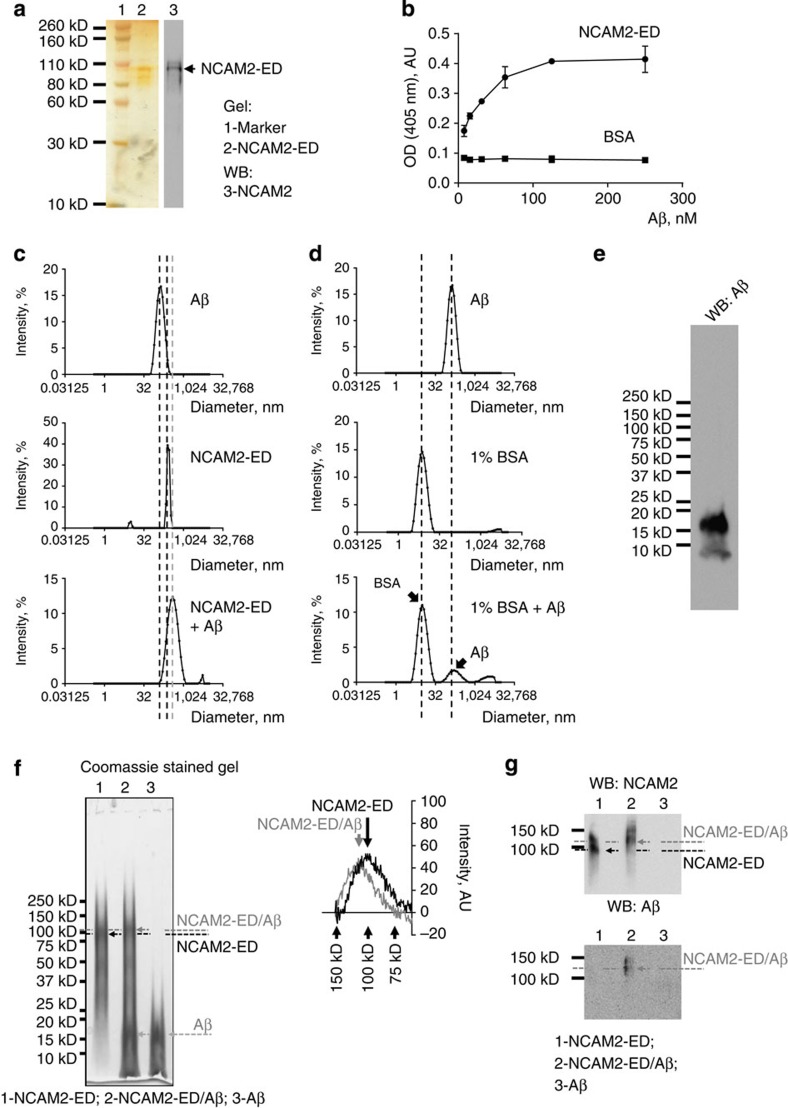
The extracellular domain of NCAM2 binds to Aβ.(a) Recombinant extracellular domains of NCAM2 (NCAM2-ED) analysed by silver staining and western blot with antibodies against the extracellular domain of NCAM2. (b) NCAM2-ED immobilized on the plastic surface of 96-well plates was assessed by ELISA for its ability to bind increasing concentrations of Aβ1-42. Mean+s.e.m. (n=3) OD values from a representative experiment are shown. Note that Aβ1-42 binds to NCAM2-ED but not to BSA in a concentration-dependent manner. The experiment was performed five times with the same effect. (c) DLS analysis of the hydrodynamic diameters of the protein particles in the solutions containing Aβ1-42 oligomers alone, NCAM2-ED alone or a mixture of Aβ1-42 oligomers and NCAM2-ED. Note that the particle size peaks (marked by black dashed lines) are shifted to a larger hydrodynamic diameter (grey dashed line) in the solution containing a mixture of Aβ1-42 oligomers and NCAM2-ED when compared with solutions containing Aβ1-42 oligomers or NCAM2-ED alone. (d) DLS analysis of the hydrodynamic diameters of the protein particles in the solutions containing Aβ1-42 oligomers alone, BSA alone or a mixture of Aβ1-42 oligomers and BSA. Note that the particle size peaks (marked by dashed lines) are not shifted when Aβ1-42 oligomers are incubated with BSA. The experiment in c,d was performed twice with the same effect and a representative experiment is shown. (e) Western blot analysis of the Aβ1–42 oligomer preparation used in this study. (f,g) PAGE (f) and western blot (g) analyses of the probes containing NCAM2-ED, NCAM2-ED incubated with Aβ1-42, or Aβ1-42 performed under non-reducing conditions. Dashed lines and arrows indicate the position of the peaks in the labelling density determined by the densitogram analysis. A fragment of the densitogram covering 75–150 kDa range is shown in f. Note that the density peak in the NCAM2 band in the probes incubated with Aβ1-42 is shifted to the higher molecular weight (grey arrows) when compared with the NCAM2 band in the absence of Aβ1-42 (black arrows). Full-length versions of the western blots are shown in Supplementary Fig. 9. OD, optical density. AU, arbitrary units.